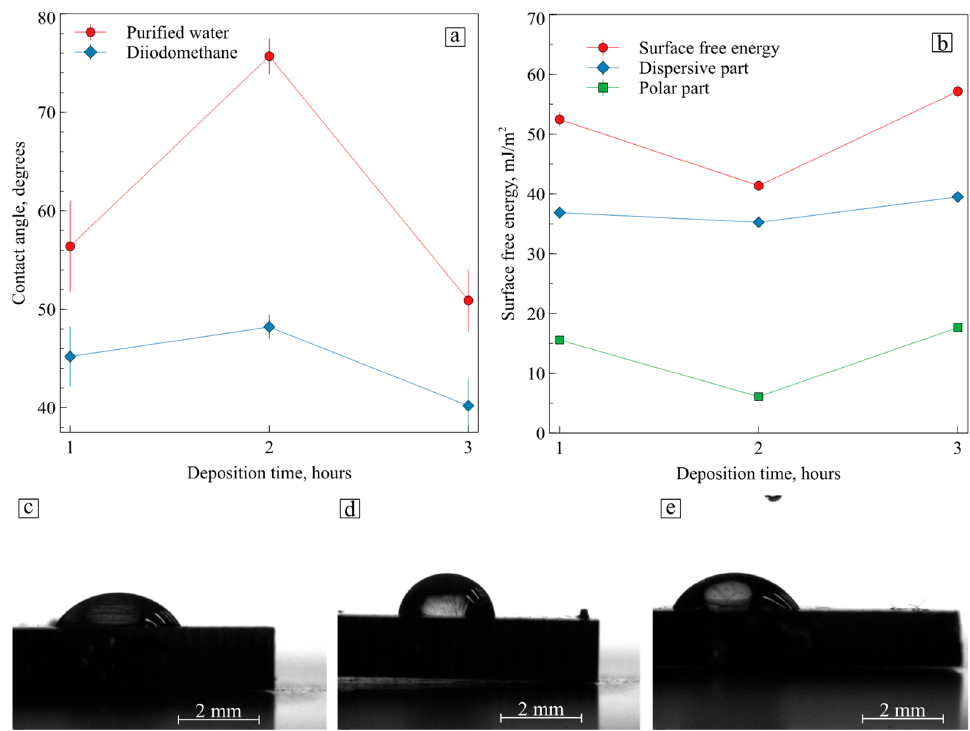
Figure 7. ( a ) Contact angle; ( b ) surface energy values of NiTi with hydroxyapatite coatings; the purified water drops on hydroxyapatite coatings deposited for: ( c ) 1 h; ( d ) 2 h; and ( e ) 3 h.